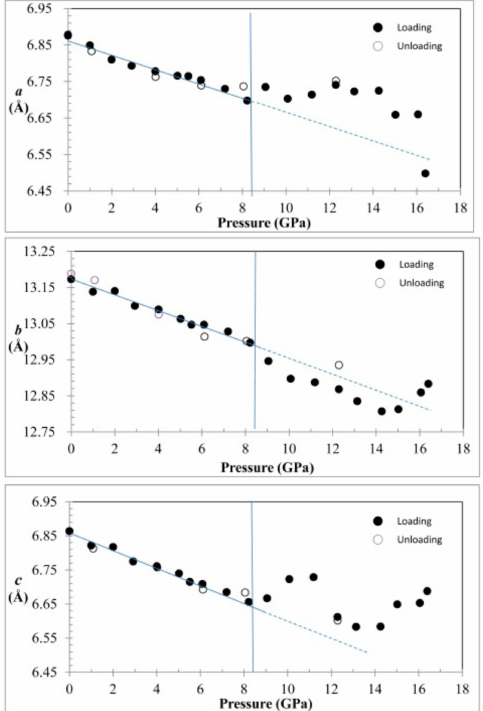
Figure 5. The compressibility of the lattice parameters ( a , b and c ) of scottyite with pressure up to 17 GPa (solid circles: loading; open circles: